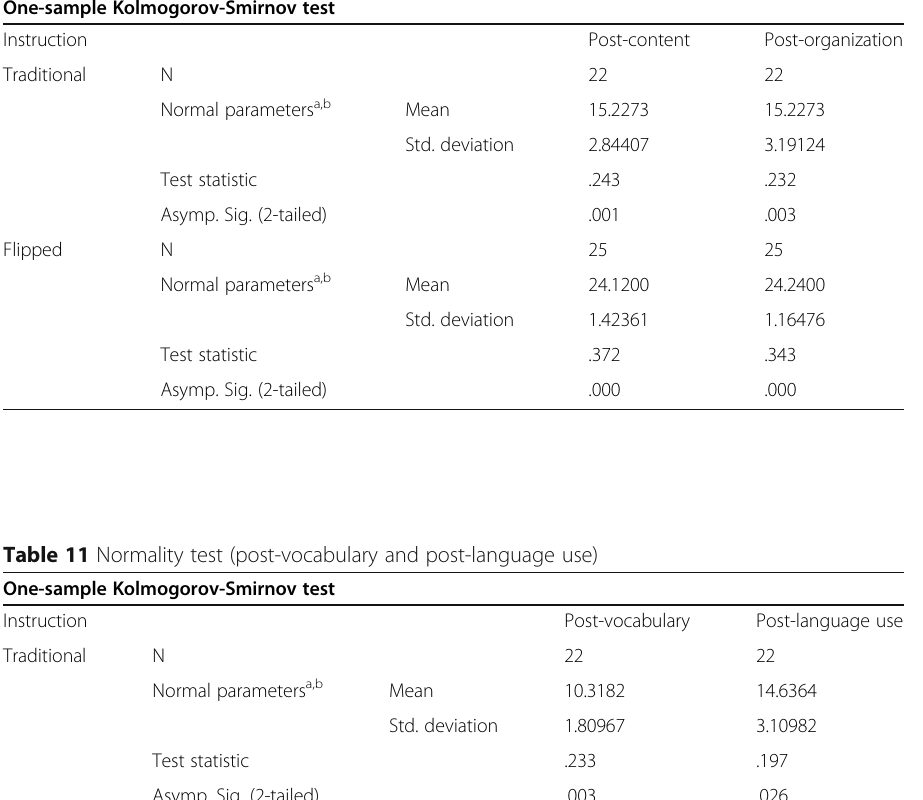
Table 10 Normality test (post-content and post-organization) One-sample Kolmogorov-Smirnov test